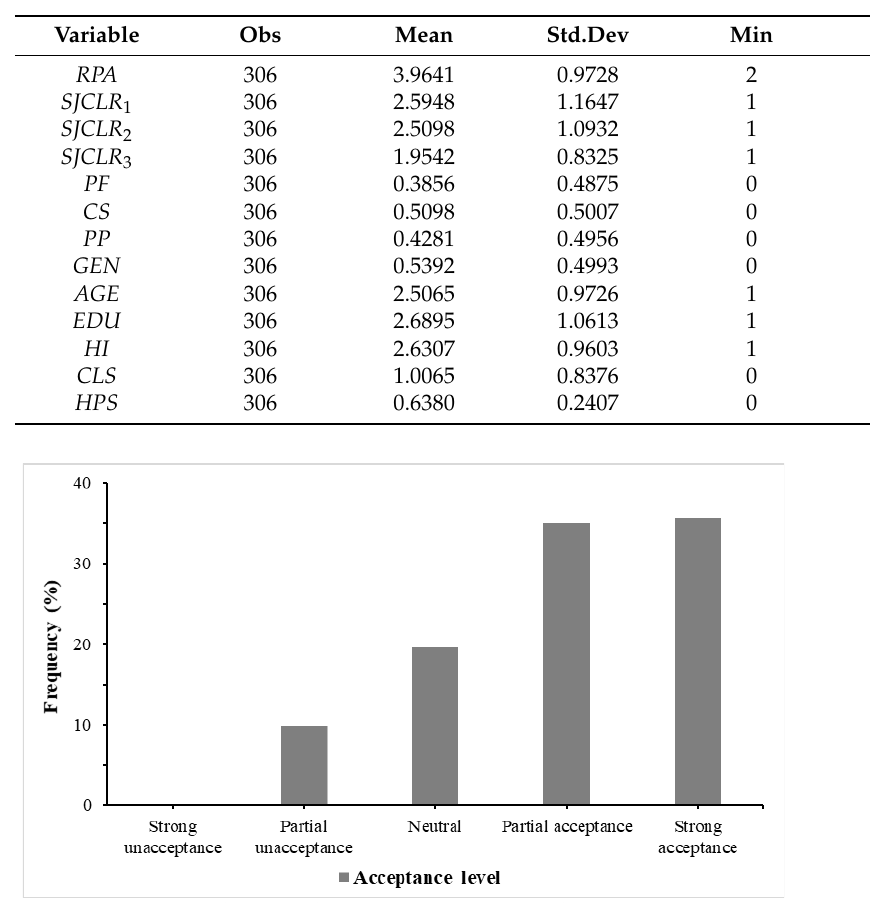
Table 3. Descriptive statistics.